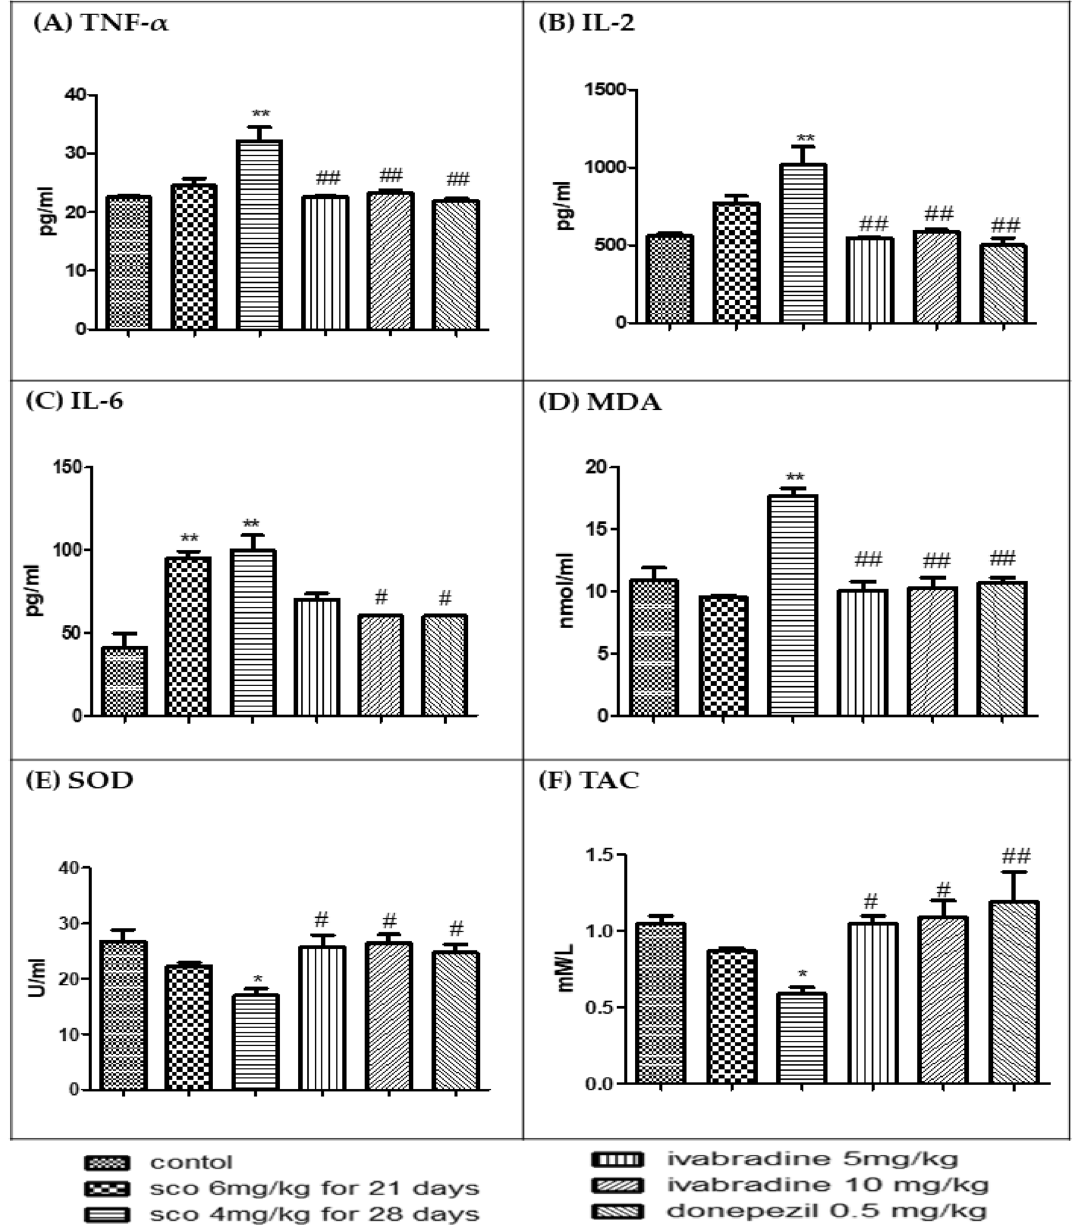
Figure 2. Analysis of inflammatory cytokines and oxidative stress: ( A ) Effect of ivabradine on hippocampal TNF-α level of scopolamine treated rats. ( B ) Effect of ivabradine on hippocampal inflammatory cytokines (IL-2) level of scopolamine treated rats. ( C ) Effect of ivabradine on hippocampal inflammatory cytokines (IL-6) level of scopolamine treated rats. ( D ) Effect of ivabradine on hippocampal lipid peroxidase (MDA) level of scopolamine treated rats. ( E ) Effect of ivabradine on hippocampal superoxide dismutase (SOD) level of scopolamine treated rats. ( F ) Effect of ivabradine on hippocampal total antioxidant capacity (TAC) level of scopolamine treated rats. *Significant (P > 0.05) difference from control group and # Significant (P > 0.05) difference from dementia control